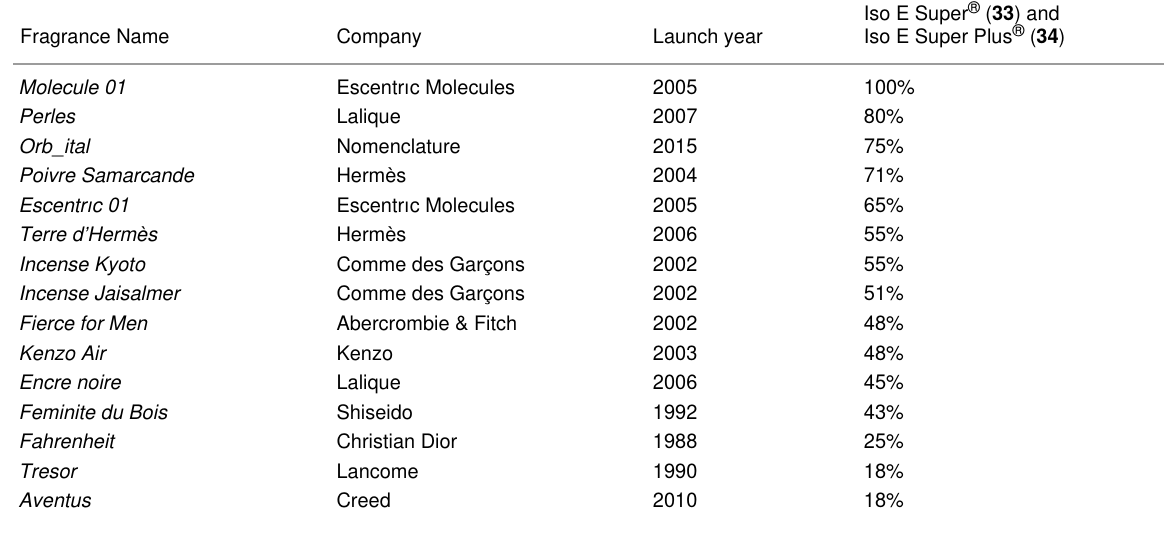
Table 2: Top fragrances with regard to their volume percentage (listed down to about 20%; the large number of perfumes with lower percentages are not listed) of Iso E Super ® in perfume oil